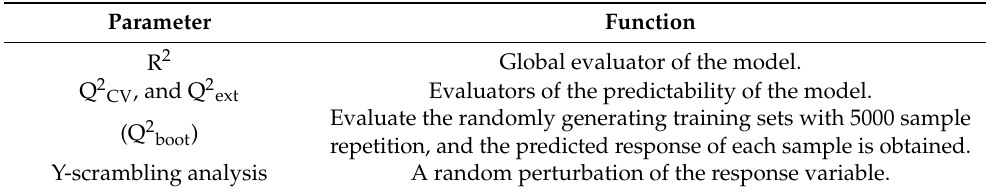
Table 1. Statistical parameters to evaluate the performance of the models. Parameter Function R 2 Global evaluator of the model. Q 2 CV , and Q 2 ext Evaluators of the predictability of the model. Evaluate the randomly generating training sets with 5000 sample (Q 2 boot ) repetition, and the predicted response of each sample is obtained. Y-scrambling analysis A random perturbation of the response